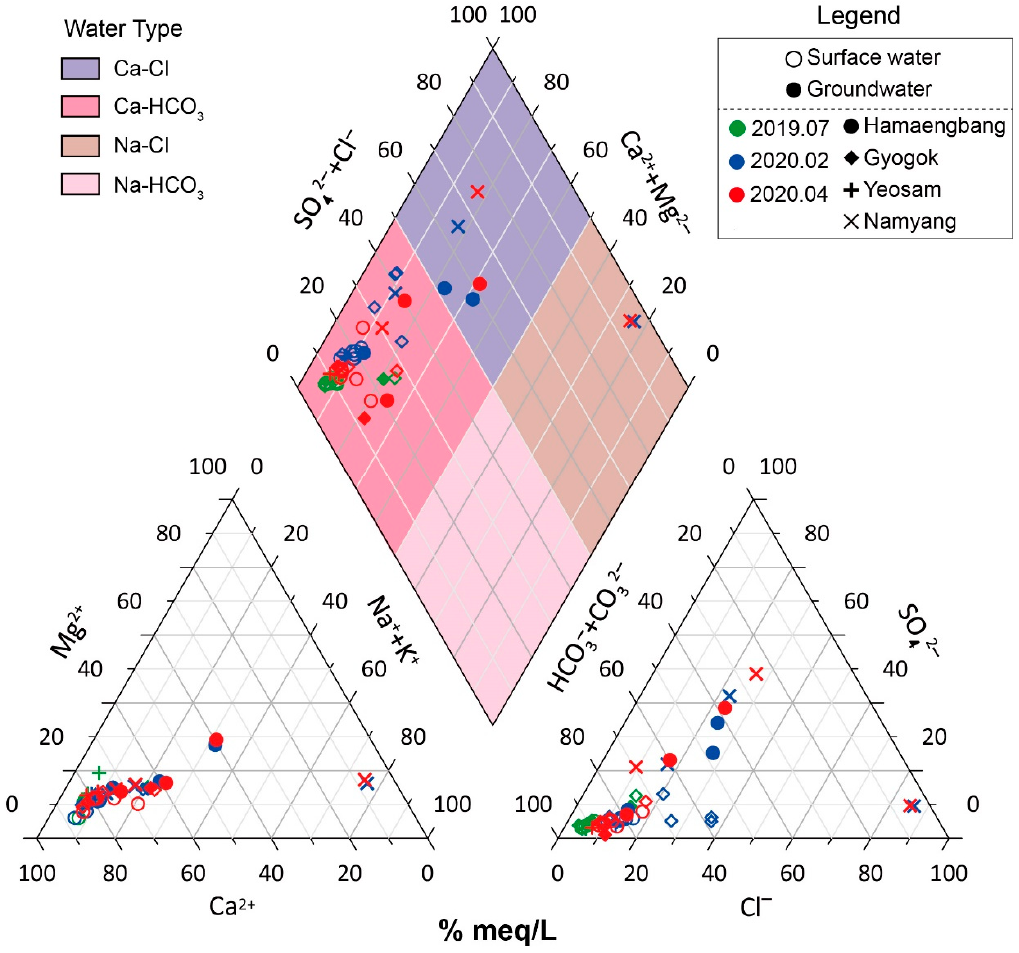
Figure 3. Water types of karst water (groundwater and surface water) samples in the study area. The Yeosam and Namyang areas contained only stream water sampling data [26].